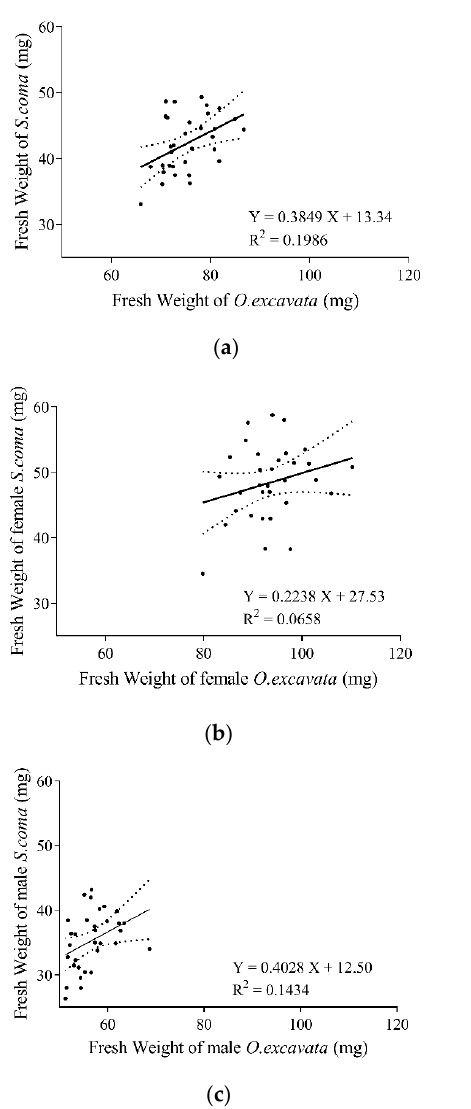
Figure 3. Influence of fresh weight of O. excavata on fresh weight of S. coma in ( a ) general, ( b ) females, and ( c ) males. Correspondingly, the influence of fat content in ( d ) general, ( e ) females, and ( f ) males, Points show the raw data. Solid lines represent the result of the general linear model, while dashed lines represent the 95%, confidence bands. Figures with a regression equation denote a significant ( p < 0.05) linear regression and without otherwise.